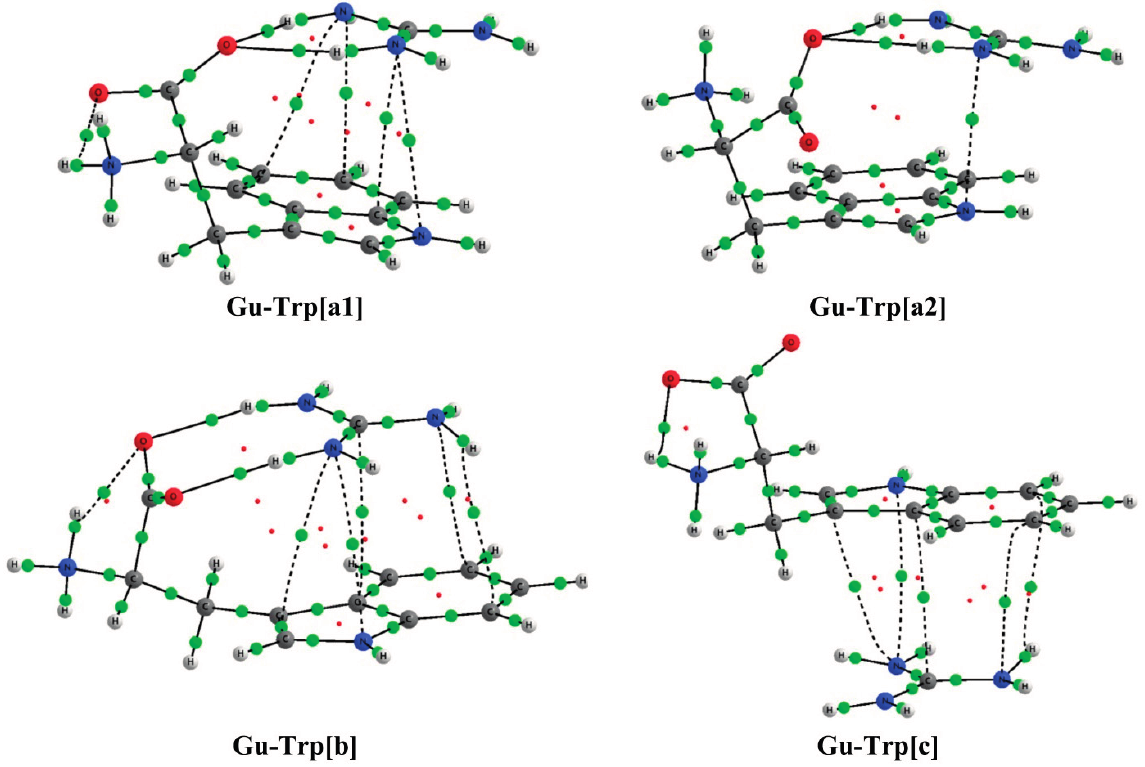
Figure 2. AIM-Molecular graphs of the Gu-Trp complexes calculated at the M06-2X/6-311++G(d,p) computational level in PCM − water. Green and red balls indicate bond and ring critical points,